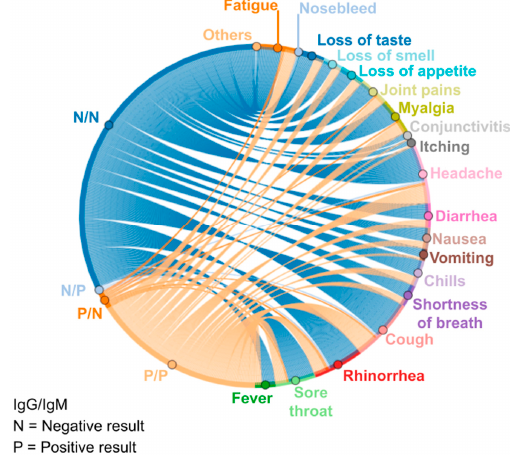
Figure 4. Symptoms correlated with positive and negative diagnoses of serological tests.